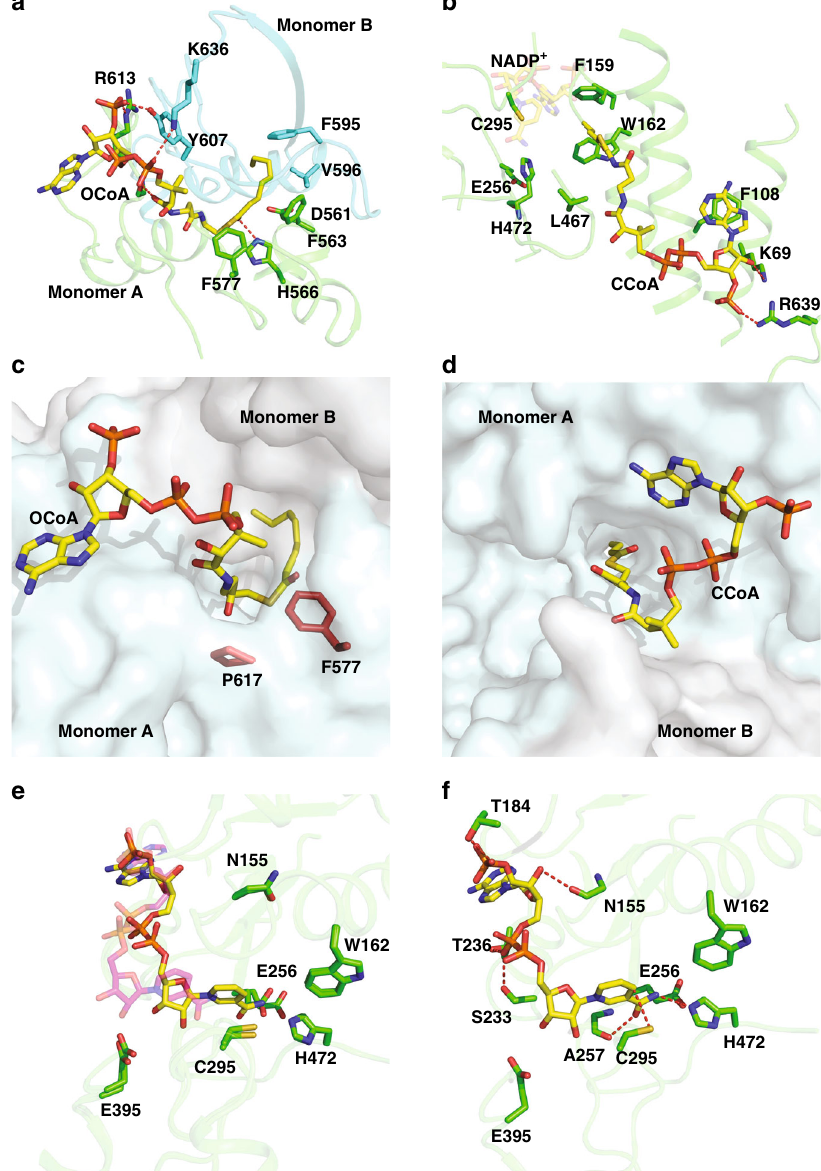
Fig. 4 Substrate binding sites in PaaZ. The binding mode and interacting residues are shown for OCoA ( a ) and CCoA ( b ), respectively. The ligands and side chains (carbon atoms in yellow and green color, respectively) are shown in stick representation. a OCoA binds at the interface of the two hydratase domains. Residues interacting with OCoA from the individual monomers are colored in green and cyan respectively. b The CoA moiety in CCoA interacts with R639, K69 and F108. NADP + and the active site residues are also shown to illustrate how the enzymatic reaction might occur. The nucleophile cysteine (C295) is buried in the core and two aromatic residues F159 and W162 are close to the hydrophobic head group of CCoA. c , d Surface representation of the enzyme showing the tunnels where the ligands OCoA and CCoA bind. One monomer is colored in cyan and the adjacent monomer in gray for clarity. In the hydratase domain, the head group of OCoA traverses and reaches the adjacent monomer. In the dehydrogenase domain, much of the interactions with the substrate is mediated by one monomer. e Overlay of the NADPH/NADP + and the active site of PaaZ + NADPH and OCoA + NADP + . The active site residues from both models are shown in stick representation with carbon atoms colored in green. The NADP + and NADPH molecules are shown in yellow and magenta, respectively. The displacement of the E256 side chain as a result of nicotinamide ring is clearly visible while other residues (such as N155, W162, H472) show no change. f The interaction of NADP + with the enzyme in the PaaZ-OCoA + NADP + model. The ligand and key residues are shown in stick representation; the carbon atoms of the ligand and the enzyme are shown in yellow and green respectively. Much of the interactions involving the phosphates of the ligand are the same as in the structure of NADPH alone. Due to the position of the ribose and nicotinamide ring close to the active site, the C4 atom is now placed near C295. The ligand is thus stabilized by the hydrogen bonds between the carbonyl and nitrogen atoms of the nicotinamide ring to E256 and